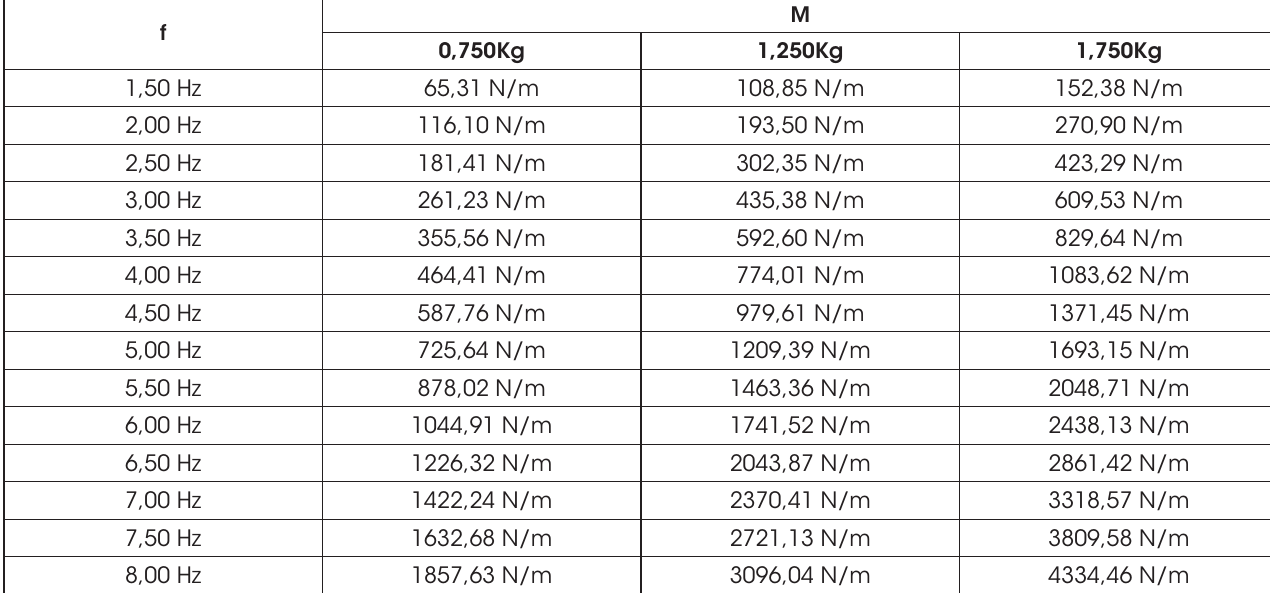
Calculated stiffness of the springs of the TMD based on the inertial element and frequencies selected